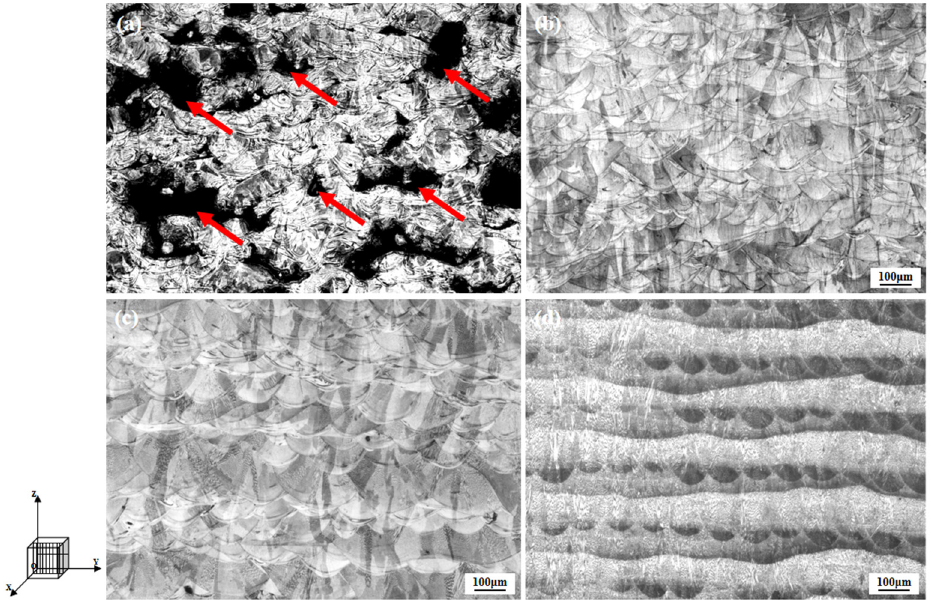
Figure 8. OM images of chemically etched surface of four samples via LPBF: ( a ) sample 3 with 18.63 J/mm 3 ; ( b ) sample 2 with 35.19 J/mm 3 ; ( c ) sample 4 with 65.00 J/mm 3 ; ( d ) sample 8 with 122.22 J/mm 3.